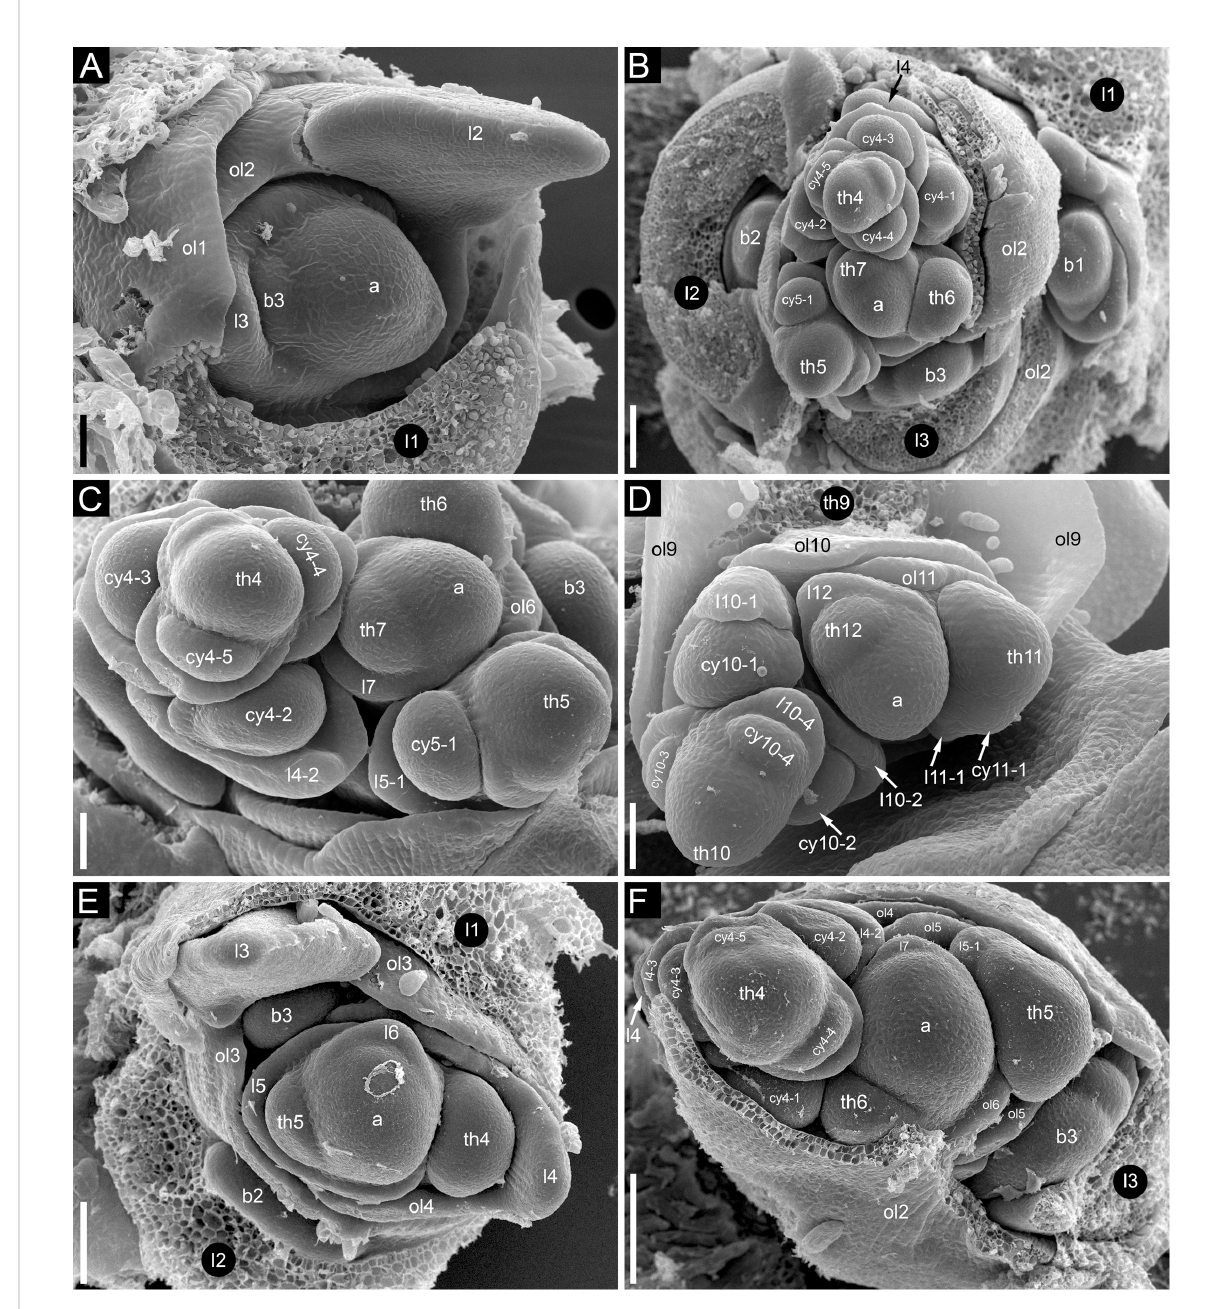
FIGURE 10 Developmental morphology of cultivars of Fagopyrum esculentum subsp. esculentum with indeterminate growth (SEM). In all instances, no terminal thyrse is produced. (A – D) cv. Batyr. (E, F) cv. Chatyr Tau. (A) Top view of young main axis with cotyledons and the fi rst proper leaf removed. (B) Subsequent developmental stage, three fi rst leaves are removed. Leaf 4 and subsequent leaves have axillary thyrses. (C) The same specimen as in (B) seen from another angle. (D) Main apex still producing lateral thyrses at a late developmental stage. (E) Top view of main axis with leaves 1 and 2 removed. (F) Top view of main axis with leaves 1 – 3 removed. In both (D) and (E) , the fi rst thyrse occurs in the axil of leaf 4. a, apex of the main axis; b, branch apex (these branches will develop as paracladia); cy, cyme; l, leaf (foliage leaf or cyme-subtending bract); ol, ocrea of leaf; th, thyrse apex (or place of removed thyrse – th9 in D ). Leaves of the main axis are numbered (cotyledons not counted). Leaves of lateral axes have double numbers, the fi rst one being the number of the main axis leaf subtending the branch. Numbers of all axillary structures are those of their subtending leaves. Scale bars = 50 µm (A, C, D) , 100 µm (B, E, F)